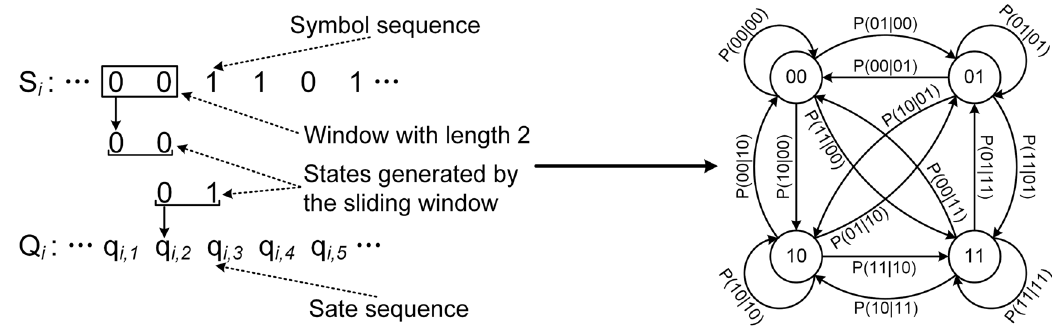
Figure 7. An example of constructing a PFSA from a symbol sequence, the left-hand of the figure indicates the generation of state sequence and the right hand indicates the constructed PFSA, in which the circle indicates the state of the PFSA and the arrow indicates the transition between the states.